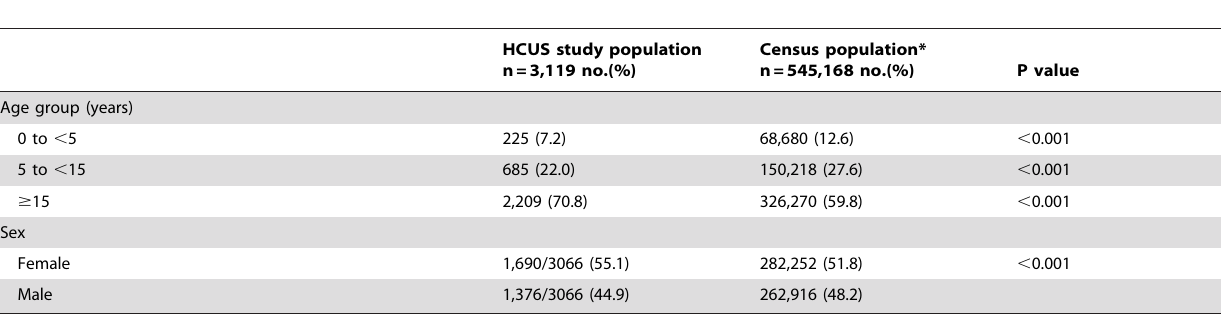
Table 1. Demographics of health care utilization study population compared to Tanzania 2002 Population and Housing Census, Moshi Urban and Moshi Rural Districts, combined.